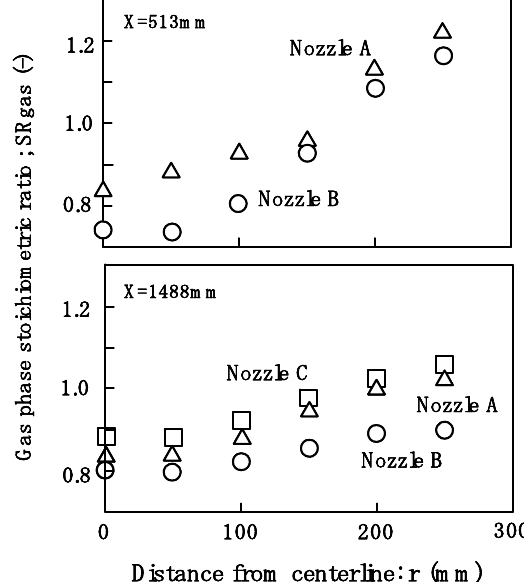
Figure 10. Distribution of gas phase stoichiometric ratio for the laboratory scale